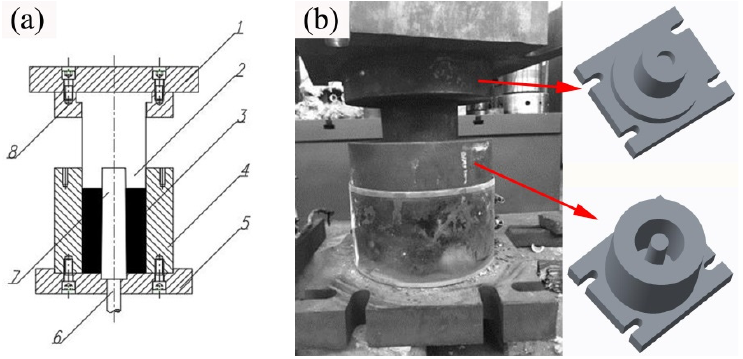
Table 3. The experimental parameters of Mg-30%Y alloy blanks.